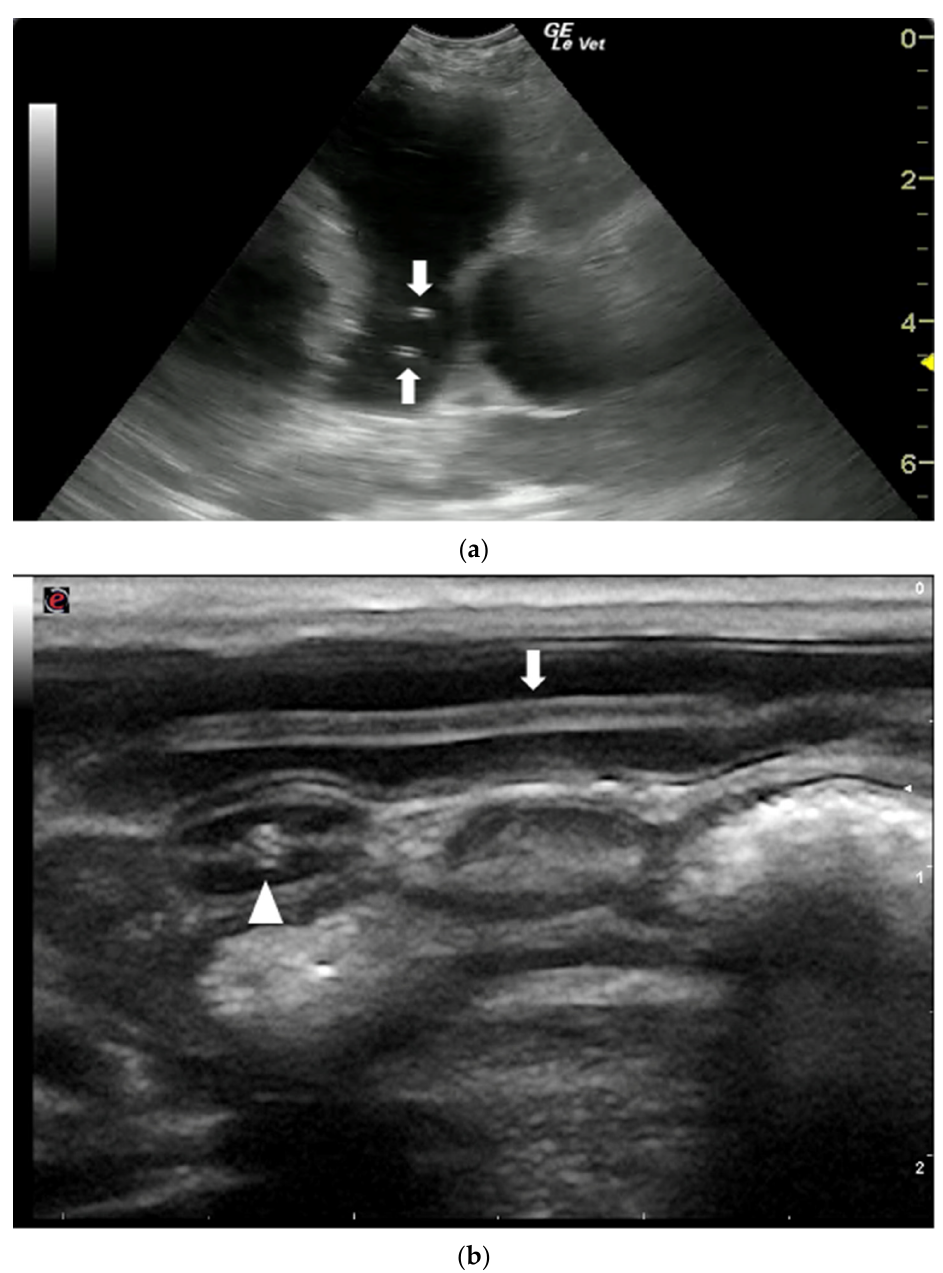
Figure 5. Ultrasonographic appearance of nematodes. ( a ) T. canis worms in the small intestine of a puppy, longitudinal (arrow) and transversal section (arrowhead) of the parasite. ( b ) Sections of adult D. immitis worms in the pulmonary artery of a dog (arrows). Courtesy of the Veterinary Teaching Hospital, University of Sassari (Italy).